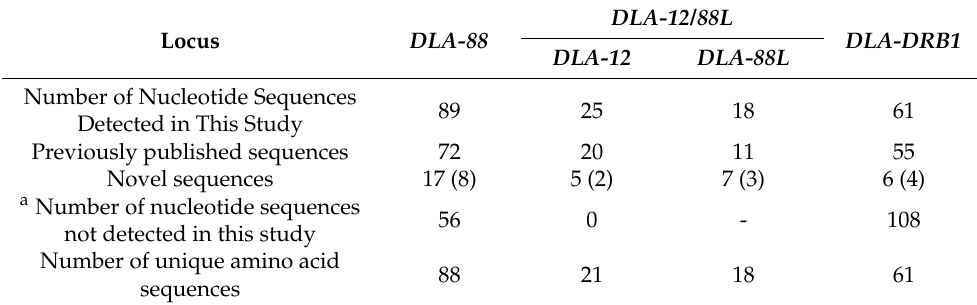
Table 2. Summary of the DLA alleles detected from 829 dogs of 59 breeds.